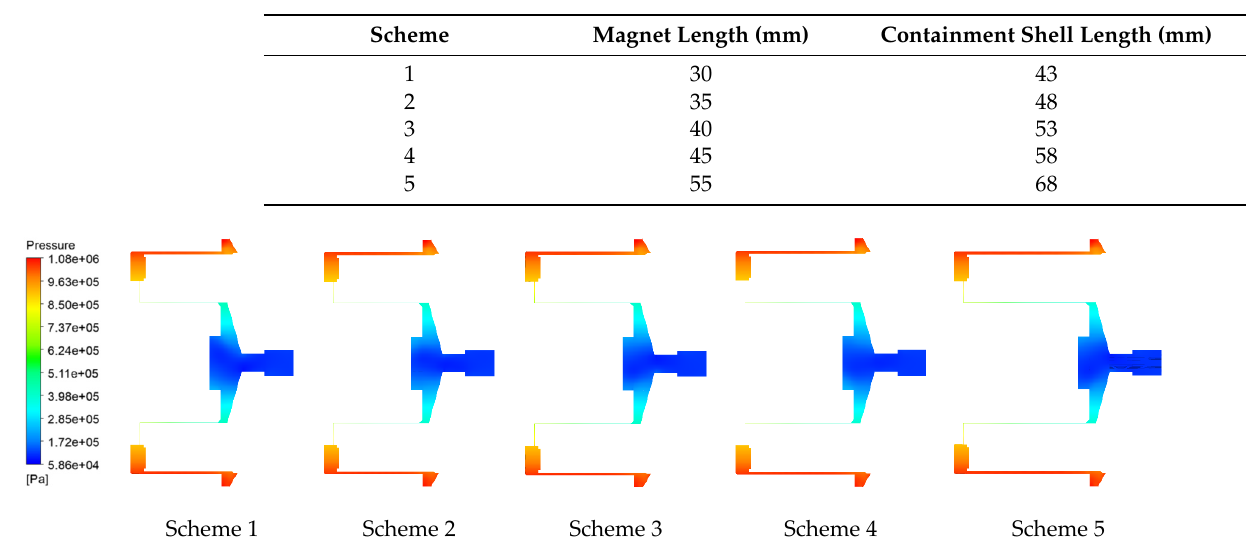
Table 4. Different design schemes of the magnetic coupling.